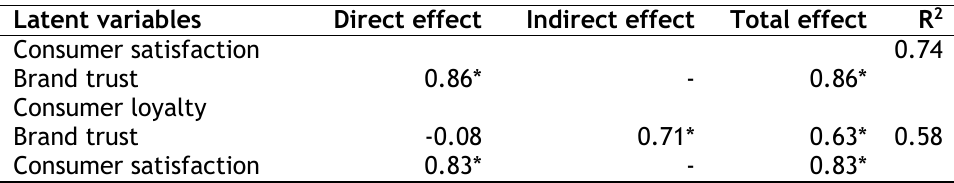
Table 6. Decomposition effects for the latent variable of consumer